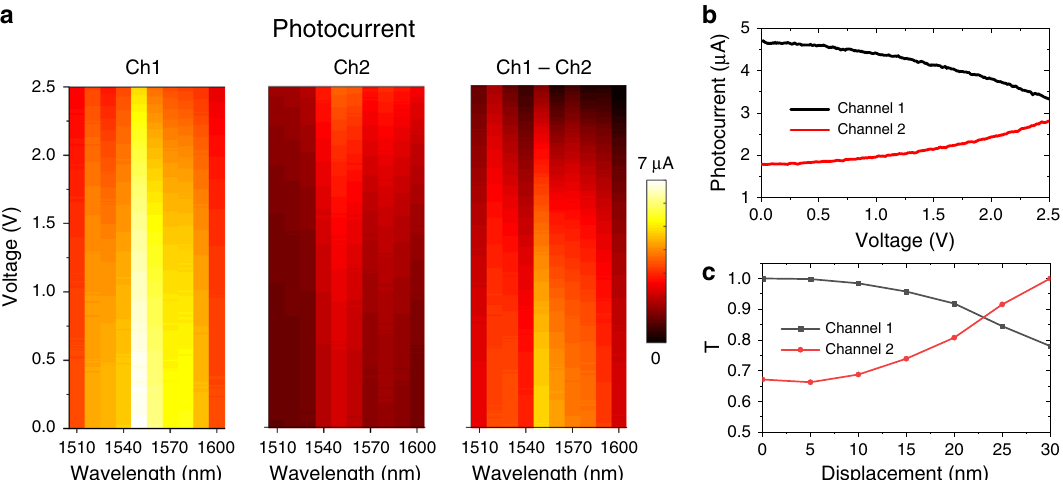
Fig. 4 Response of the senor under a static actuation. a Photocurrent of the two detectors and their difference, as a function of reverse bias voltage on the actuator, for an on-chip laser power of 0.3 mW. b Measured photocurrent at 1540 nm as a function of bias voltage. c Simulated transmittance at 1540 nm as a function of the displacement of the suspended